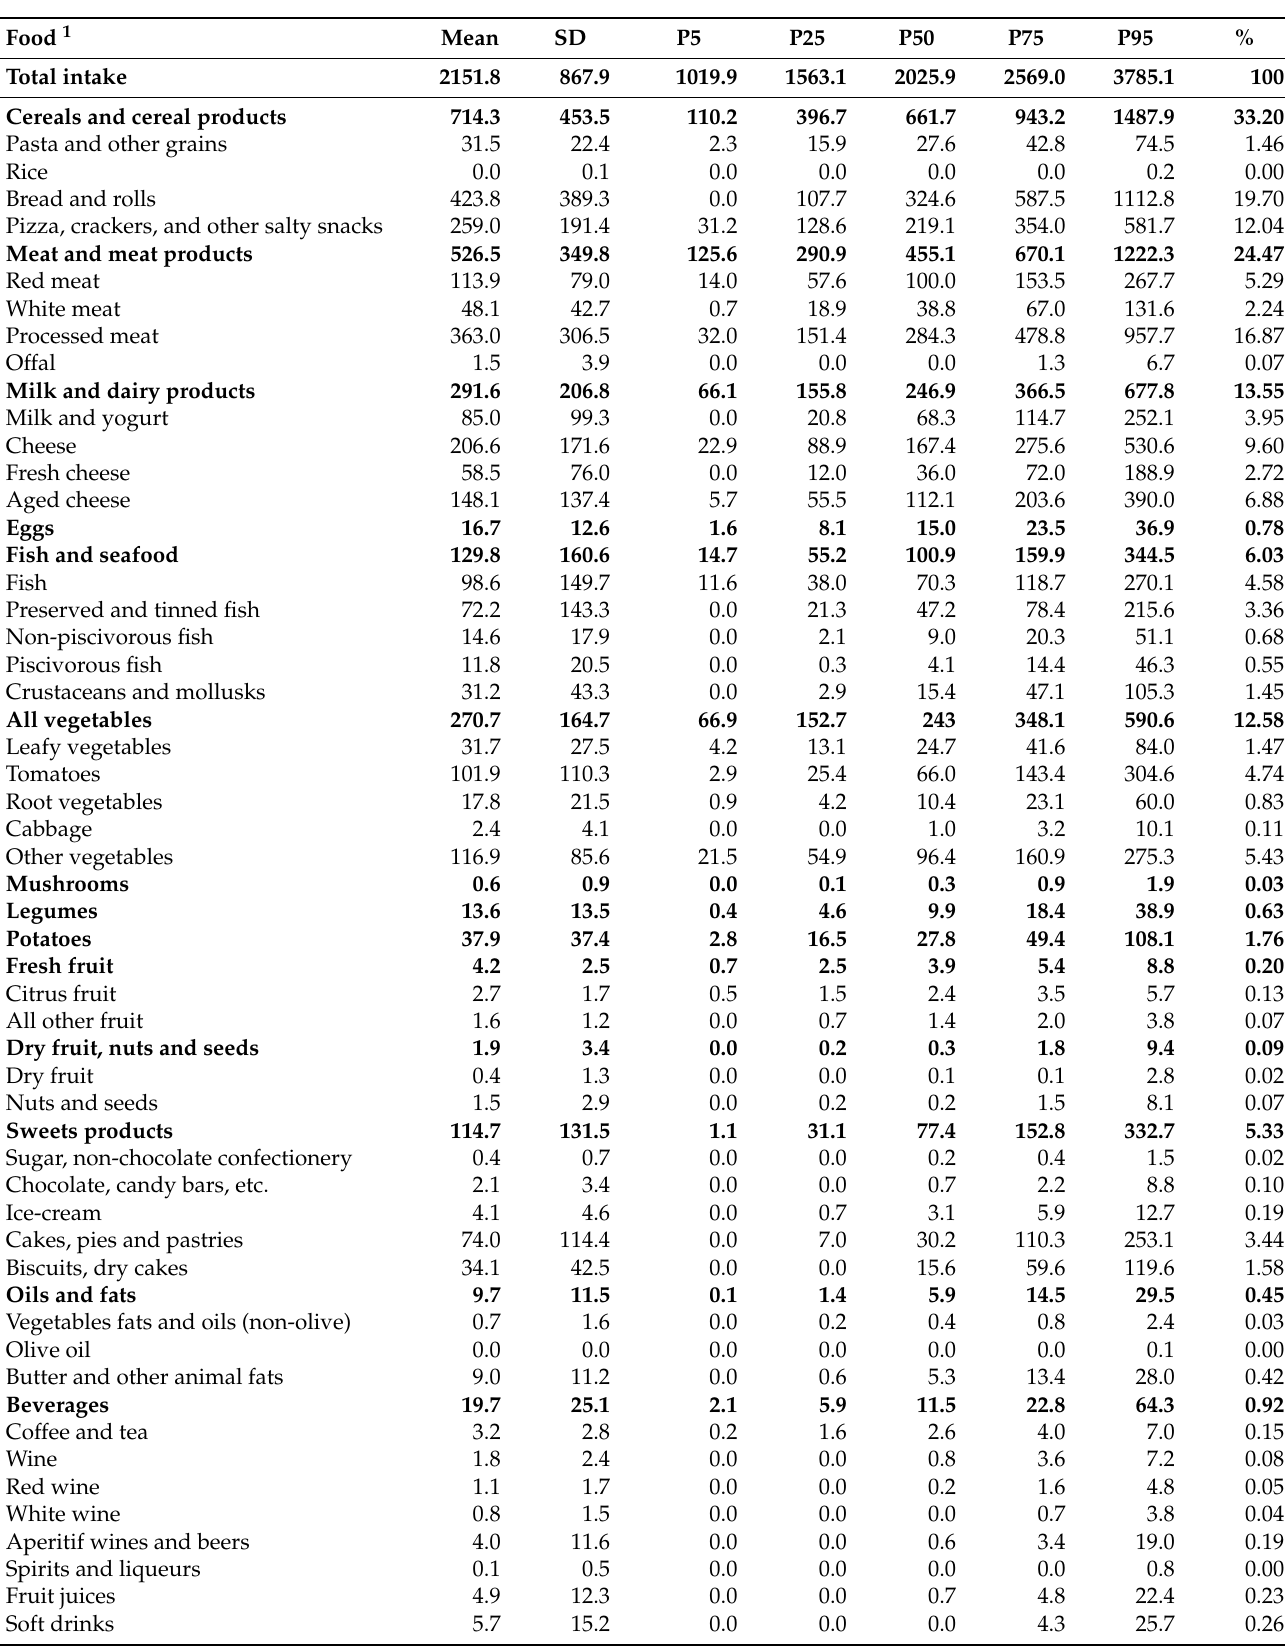
Table 3. Distribution of sodium daily dietary intake in all subjects (in mg/day) and percentage contribution (%) of each food to total